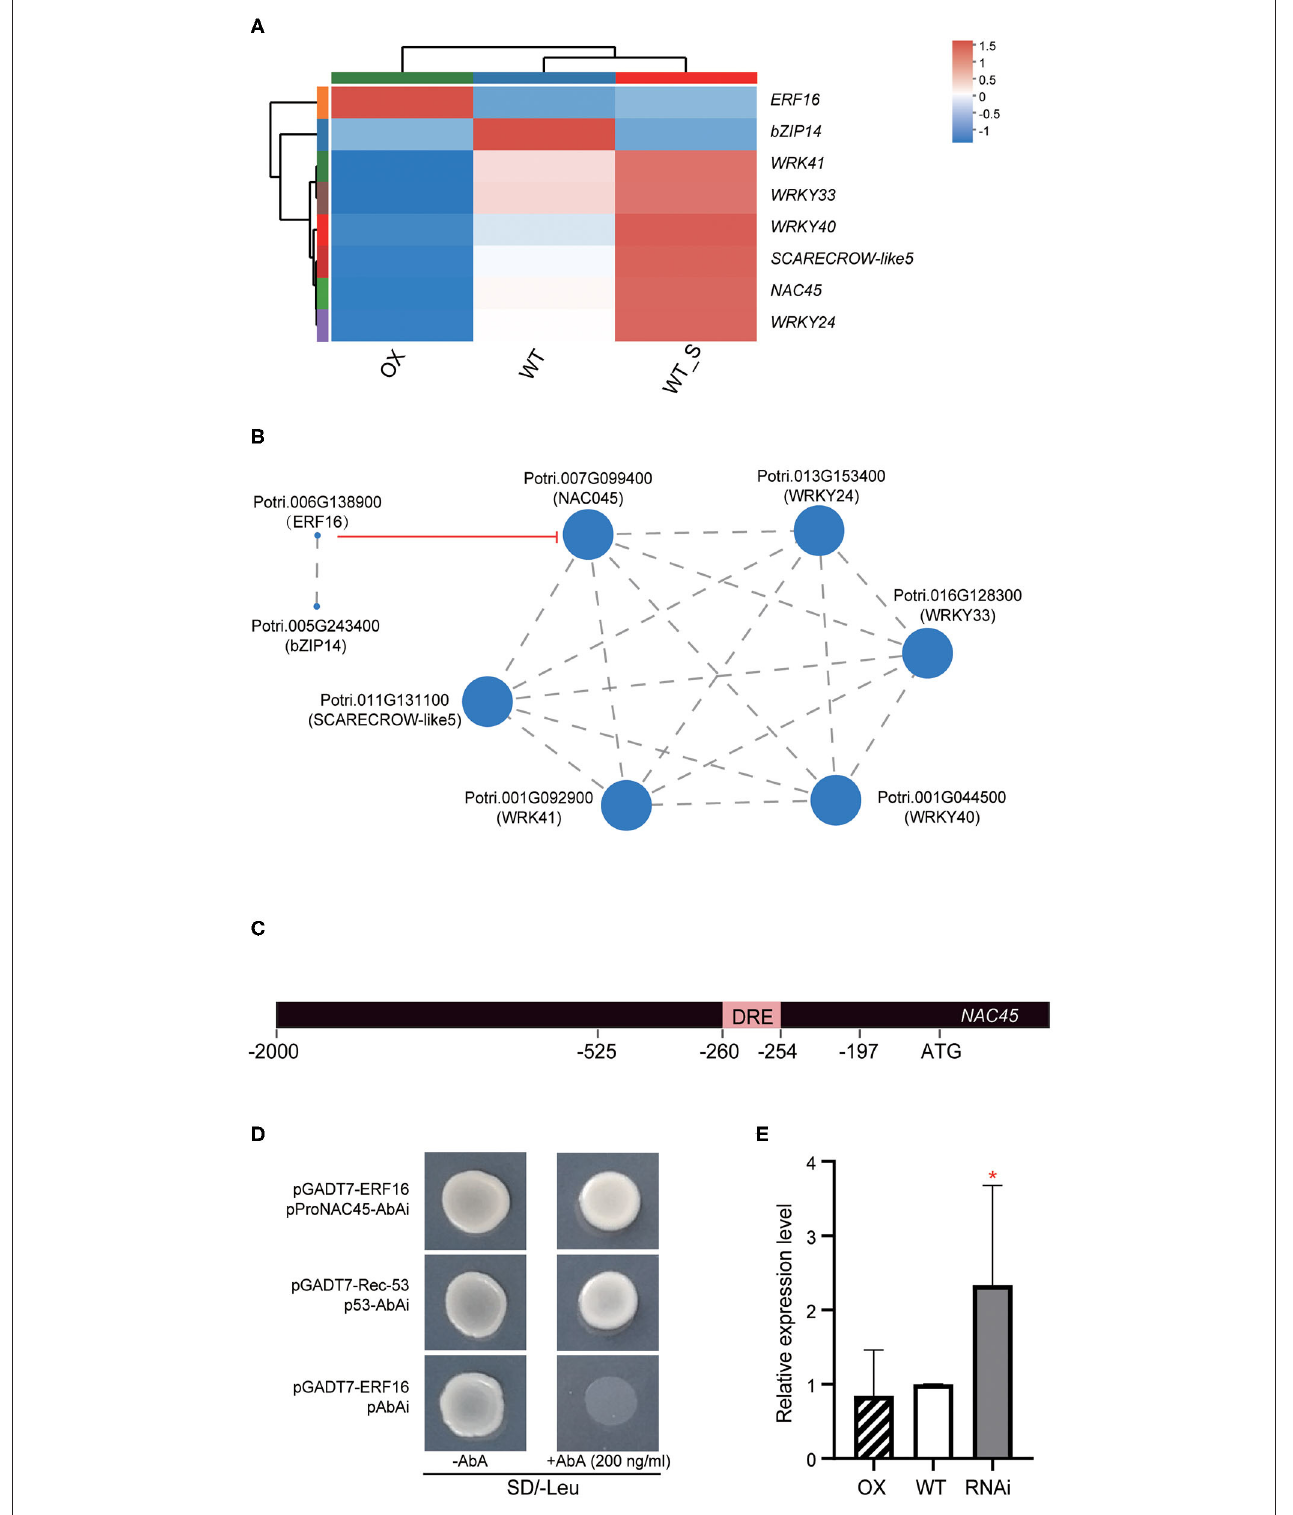
FIGURE 6 | PagERF16 negatively regulated the expression of NAC45. (A) Expression pattern of differentially expressed TFs related to salt stress and PagERF16. WT_S, WT treated with 100 NaCl for 48h. Red denotes high expression and blue indicates low expression. (B) Correlation analysis of co-expressed TFs using